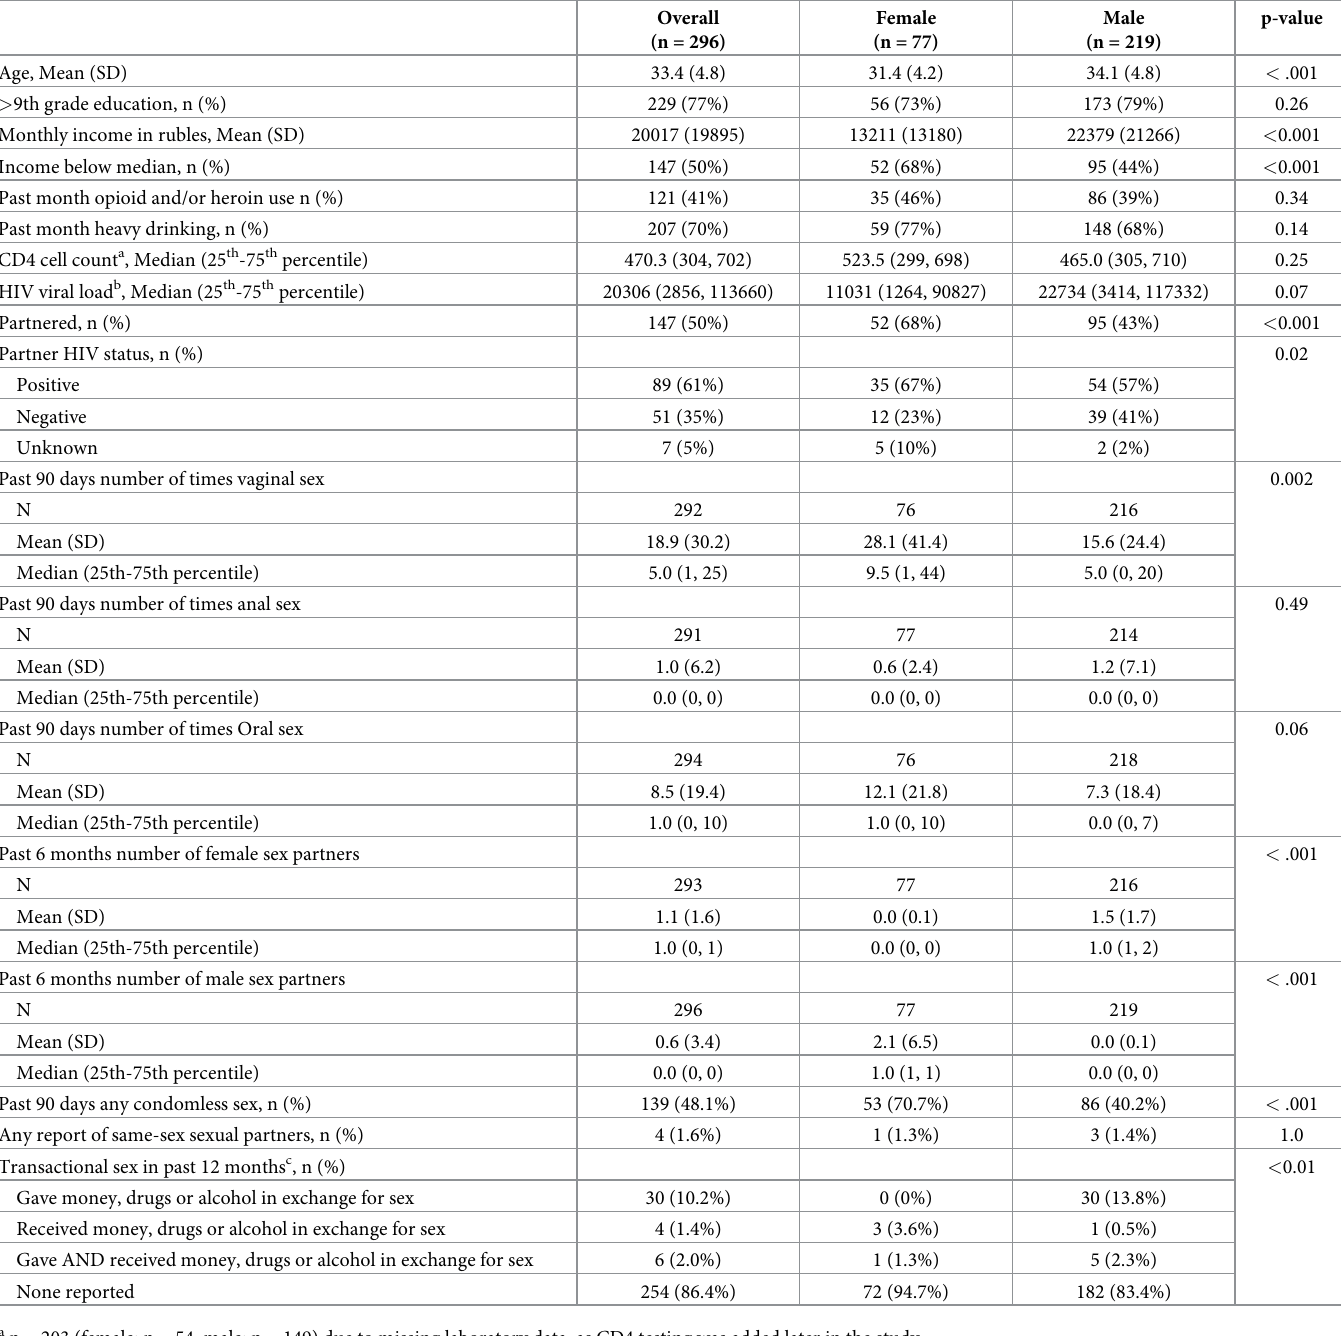
Table 1. Baseline demographics and HIV factors in a cohort of PLWH not on ART who inject drugs in St. Petersburg, Russia (n =